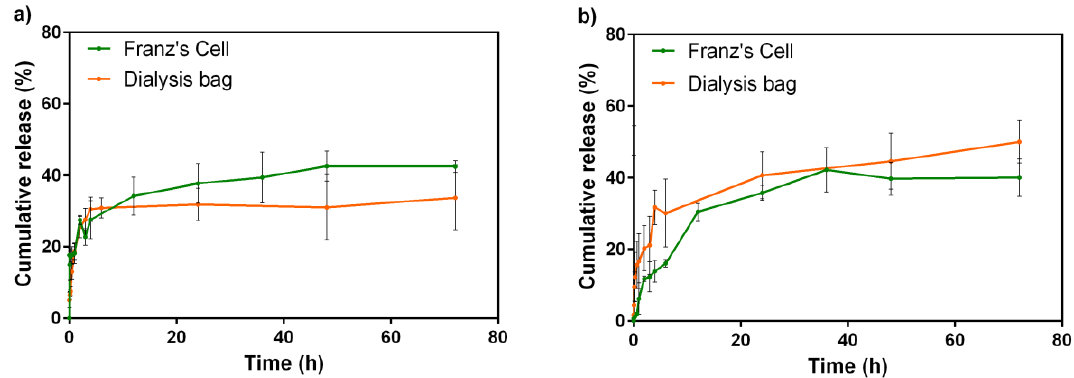
Figure 6. Cumulative release of Rhodamine 123 (%) at ( a ) 25 °C and ( b ) 37.5 °C during 72 h. n = 3 ± SD.